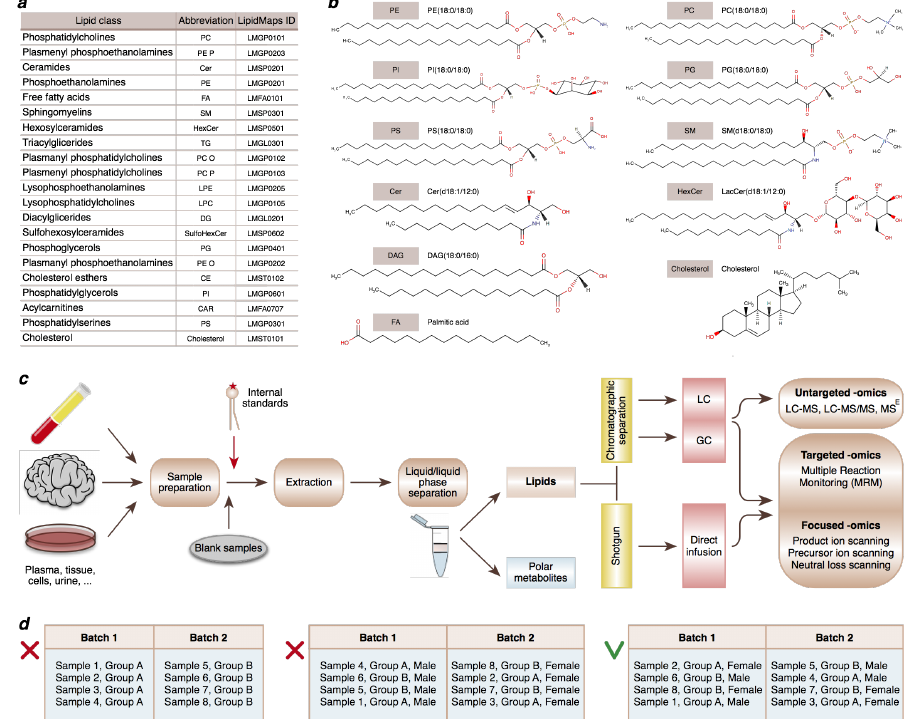
Figure 1. Lipid classes and lipidomics techniques discussed in this study. ( a ) Abbreviations and LIPIDMAPS identifications of lipid classes [13]. ( b ) Examples of prominent representatives of lipid subclasses [14]. ( c ) Experimental approaches that can be applied in lipidomics research. LC-MS and GC-MS are based on the separation of different lipid categories using extraction and chromato- graphic separation prior to mass analysis. Shotgun lipidomics omits chromatographic separation and analyzes all lipid classes together, directly infusing them into the mass spectrometer. ( d ) Balancing confounding factors between batches is an essential step of study